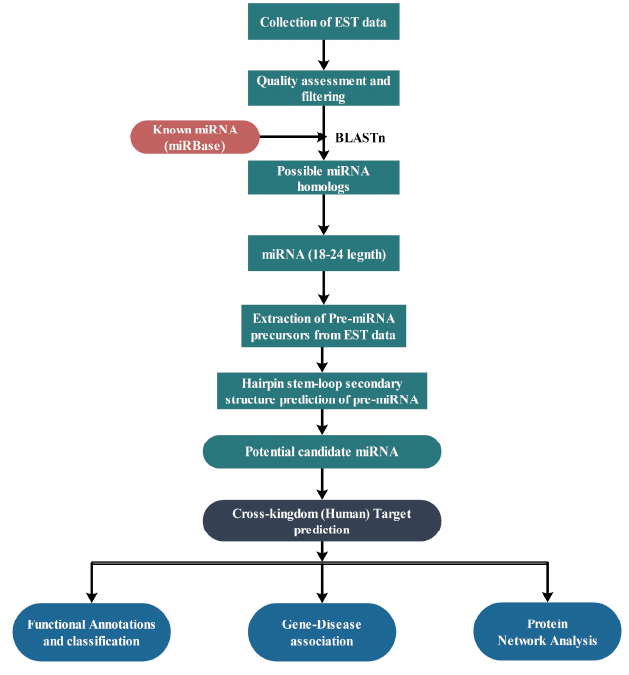
Figure 4. Brief workflow of the study.